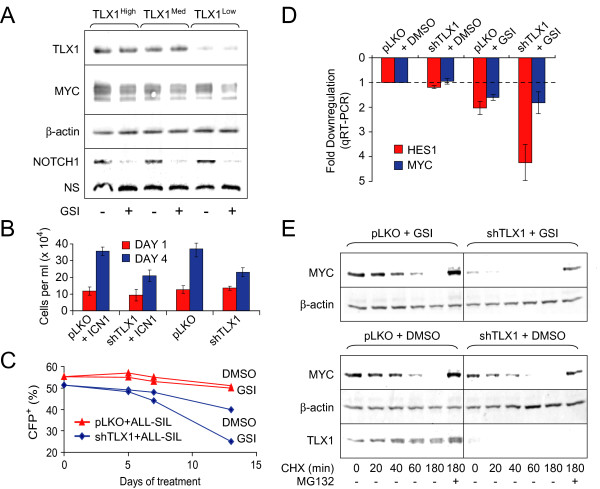
TLX1 and NOTCH coregulate MYC levels and ALL-SIL growth. (A) ALL-SIL derivatives expressing the indicated levels of TLX1 were treated for 24 hours with 500 nM Compound E (GSI, +) and 0.05% DMSO (GSI, -) as vehicle control. Whole cell lysates were analyzed for expression of activated NOTCH1 and MYC proteins by Western blotting. A representative blot of 4 biological replicates is shown. (B) Activated NOTCH1 expression does not compensate for the lack of TLX1. ALL-SIL cells expressing the TX1 shRNA95 or pLKO.1-CFP control vector were lentivirally transduced to express a constitutively active form of NOTCH1 (ICN1). Cells were seeded at 1 × 105 cells per ml in parallel with mock-transduced controls and counted on days 1 and 4 by trypan blue staining. (C) Growth competition experiments in the presence or absence of 500 nM Compound E, indicated as GSI and DMSO, respectively. ALL-SIL cells expressing TLX1 shRNA95 and CFP or pLKO.1-CFP were mixed with parental ALL-SIL cells in equal proportions. Mixed populations were divided, treated with GSI or DMSO control for up to 3 weeks and periodically examined by flow cytometric analysis. (D) TLX1 and NOTCH regulation of MYC and HES1 mRNA. (E) TLX1 prevents GSI-induced downregulation of MYC protein and extends MYC half-life. Cells were treated with 500 nM Compound E or DMSO control for 24 hours, then assayed for MYC protein levels and stability using 50 μg/ml cycloheximide or 40 μM MG132 treatment for the indicated times.